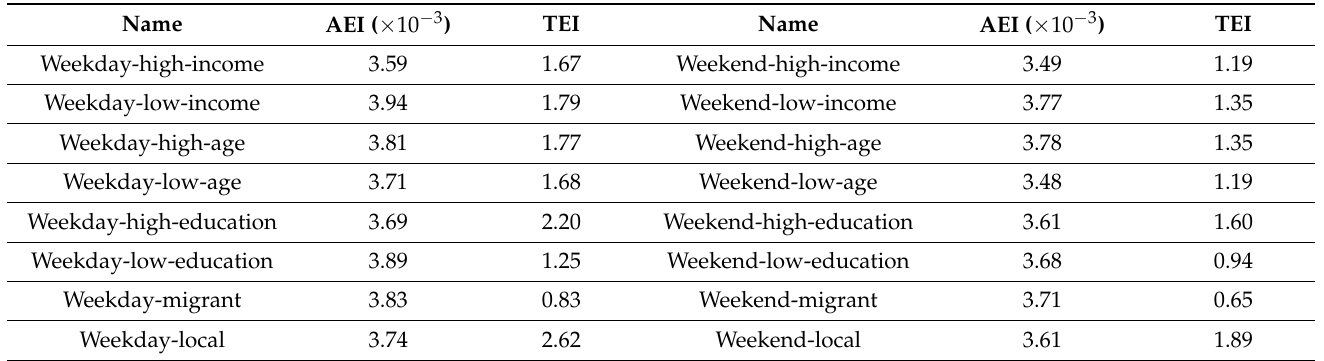
Table 2. Average exposure indicator (AEI) and total exposure indicator (TEI) of each group.